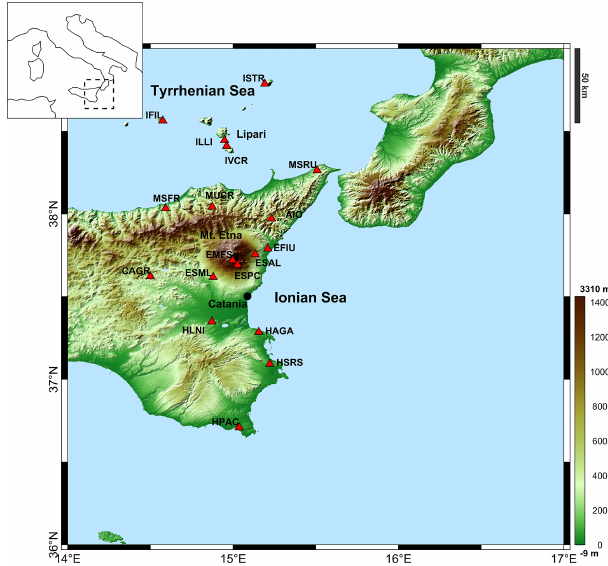
Figure 1. Map of eastern Sicily with the location of the seismic stations (red triangles) used in this work. The top left panel shows where the area is located in Italy. The map was drawn by using NASA Shuttle Radar Topography Mission (SRTM) data and the readhgt.m Matlab ® function (Beauducel,